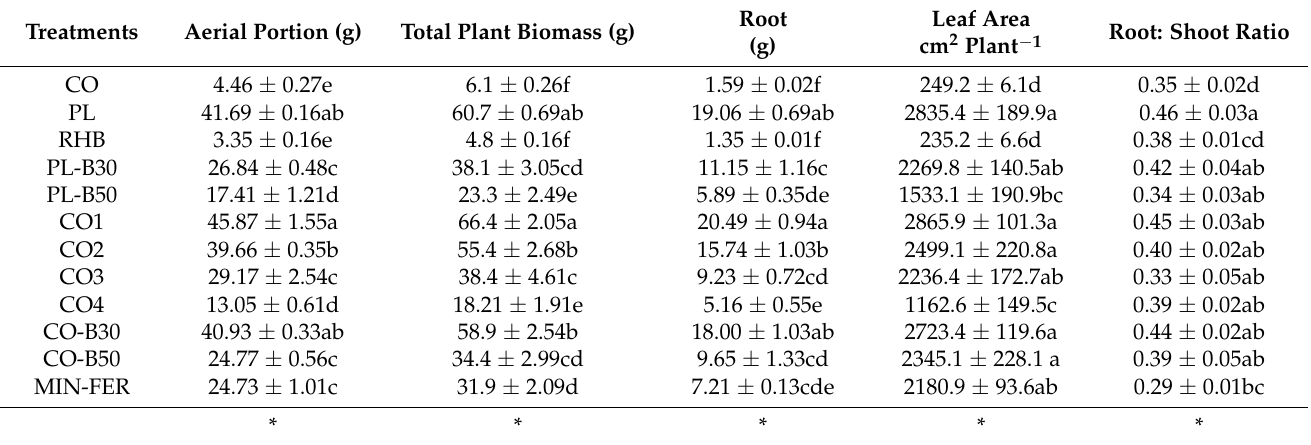
Table 4. Plant parts biomass at